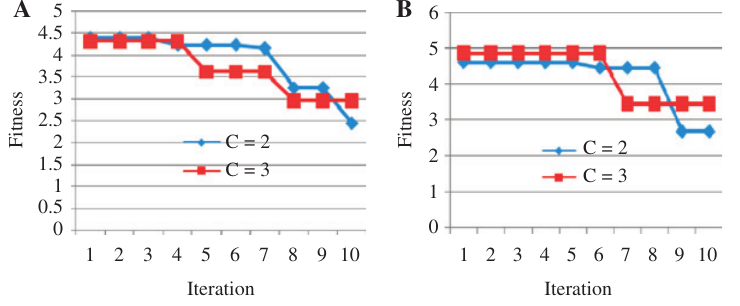
Figure 3: Convergence Analysis Curve. (A) Iris dataset. (B) Wine